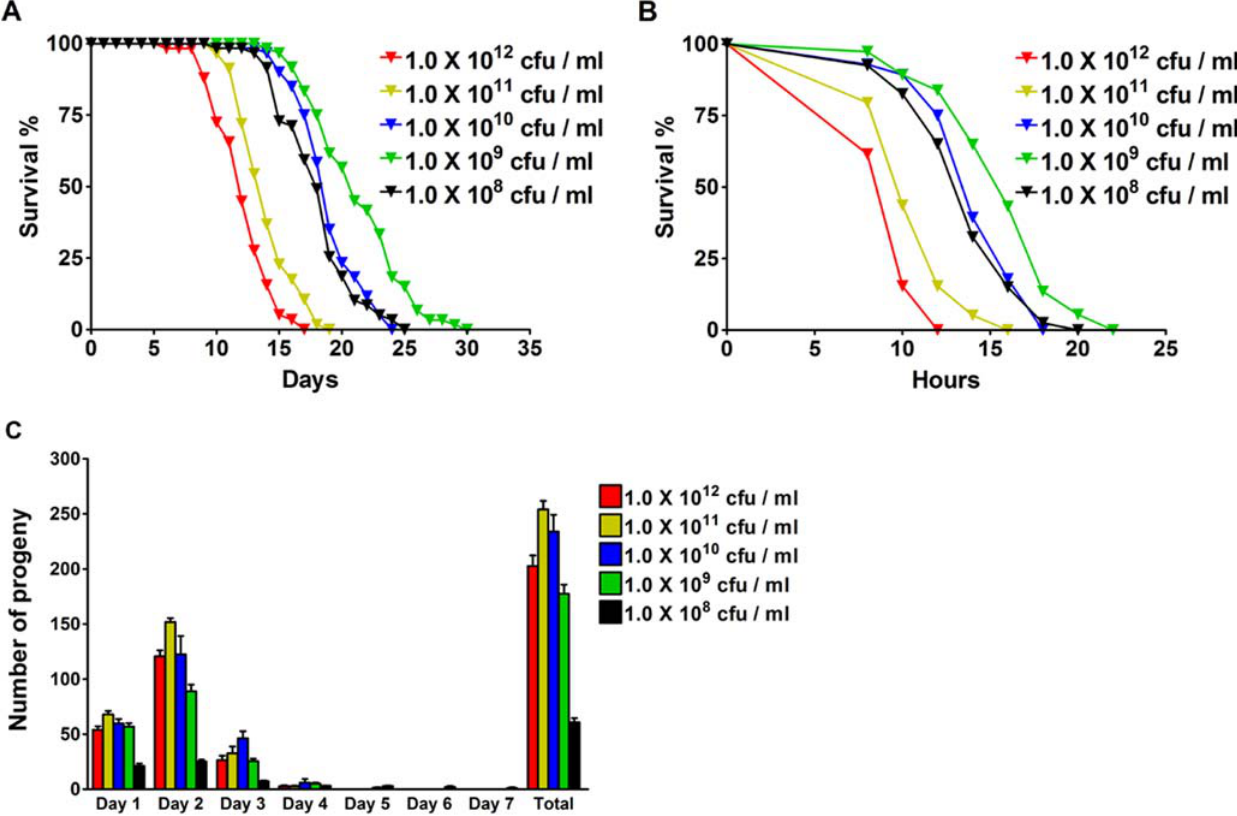
Figure 2. DR extends lifespan, increases stress resistance and decreases fecundity in C.elegans . (A) Survival curves of N2 animals fed with E. coli at different concentrations (1.0 6 10 8 to 1.0 6 10 12 cfu/ml) during adulthood. Mean lifespan was 12.2 days for 1.0 6 10 12 cfu/ml, 14.0 days for 1.0 6 10 11 cfu/ml, 18.9 days for 1.0 6 10 10 cfu/ml, 21.2 days for 1.0 6 10 9 cfu/ml, and 18.0 days for 1.0 6 10 8 cfu/ml. (B) Heat stress resistance of adults after maintenance under different nutrient conditions. Mean survival was 9.5 hours for 1.0 6 10 12 cfu/ml, 10.9 hours for 1.0 6 10 11 cfu/ml, 14.3 hours for 1.0 6 10 10 cfu/ml, 15.9 hours for 1.0 6 10 9 cfu/ml, and 13.8 hours for 1.0 6 10 8 cfu/ml. (C) Egg production after maintenance under different nutrient conditions. Average brood sizes were 203 6 37 for 1.0 6 10 12 cfu/ml, 254 6 30 for 1.0 6 10 11 cfu/ml, 234 6 60 for 1.0 6 10 10 cfu/ml, 178 6 32 for 1.0 6 10 9 cfu/ml, and 61 6 15 for 1.0 6 10 8 cfu/ml. Fifteen animals were scored for each food concentration.